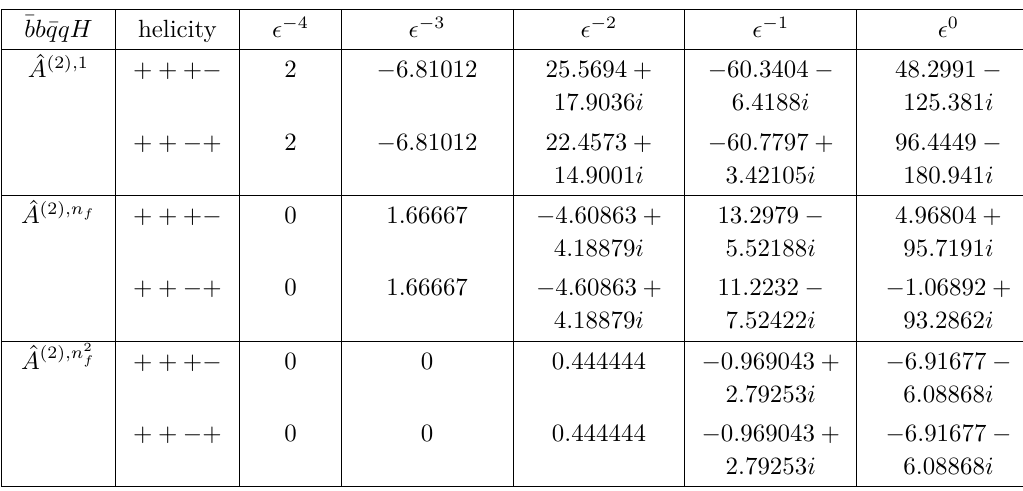
Table 3. Numerical values of the bare ¯ bbggH partial amplitudes at two loops (normalised to the tree-level amplitude) at the kinematic point in eq. (6.11) for the four independent helicity configurations and the various closed fermion loops contributions.